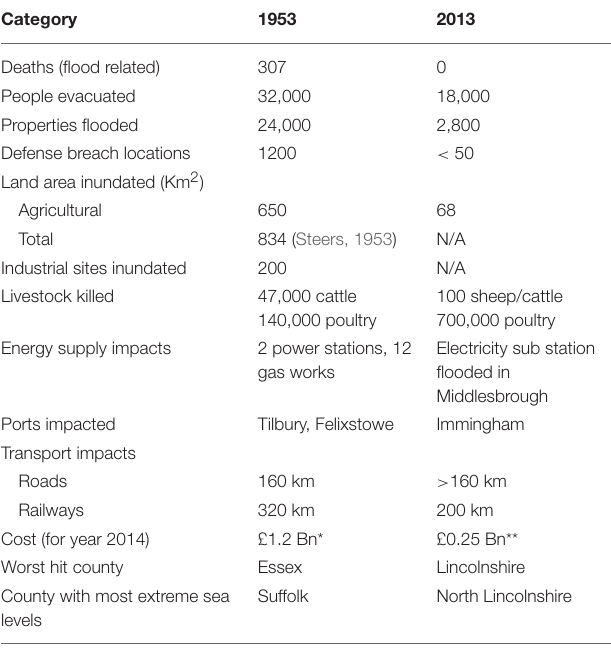
TABLE 3 | Summary of the impacts during the 1953 and 2013 events in the UK, primarily from data compiled by the Environment